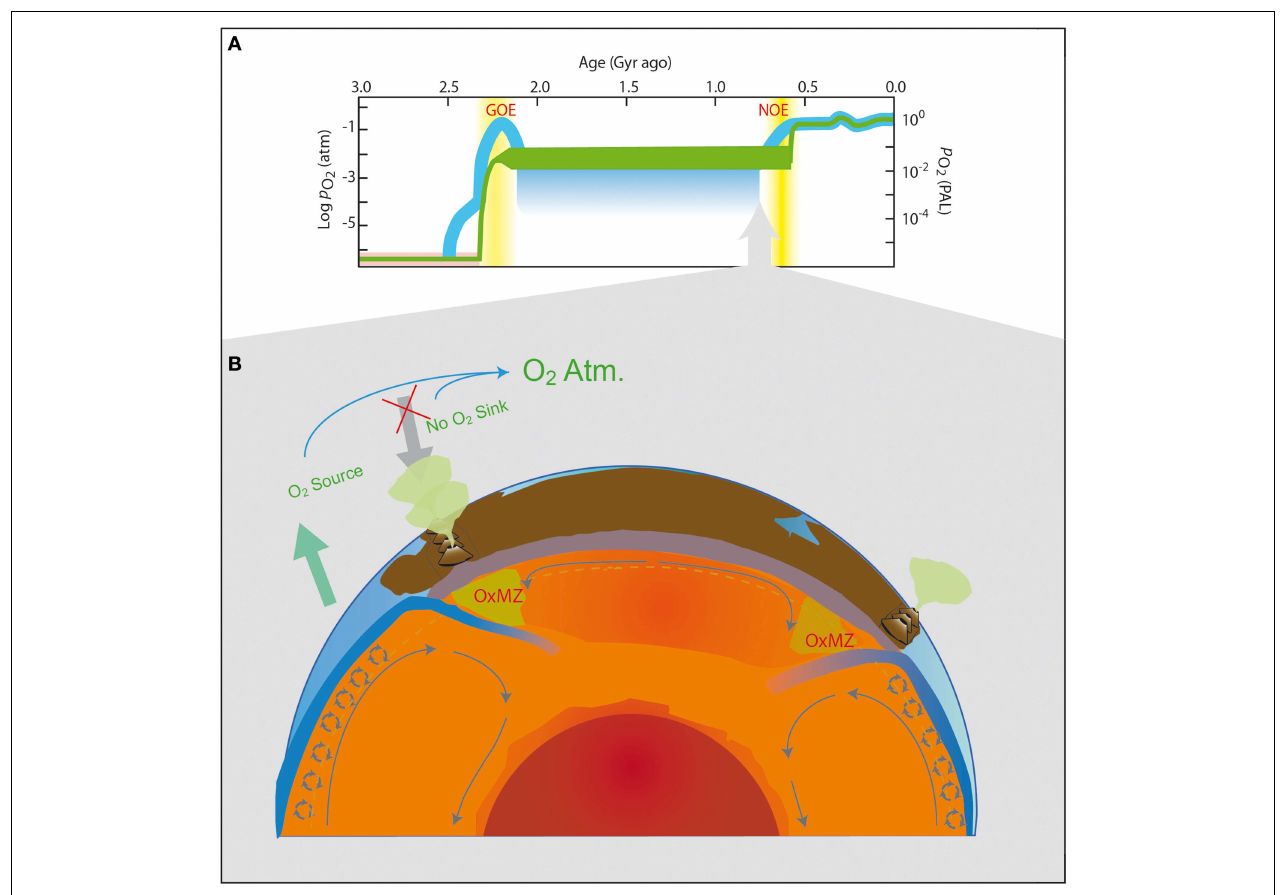
FIGURE 1 | (A) Evolution of Earth’s atmospheric oxygen content between 3.5 Ga and present (from Lyons et al., 2014). PO 2 is the atmospheric partial pressure of O 2 and PAL is the present atmospheric level. The green and blue curves depict a two-step evolution of atmospheric evolution ( Kump, 2008) and a recent model (Lyons et al., 2014), respectively. In yellow are the classical time windows for the GOE (Great Oxydation Event) and NOE (Neoproterozoic Oxydation Event). (B) Model of Cryogenian Oxygen cycle and subduction zones in the frame of Rodinia. Green zones highlight the suspected hot and oxidized magma zone (OxMZ) under